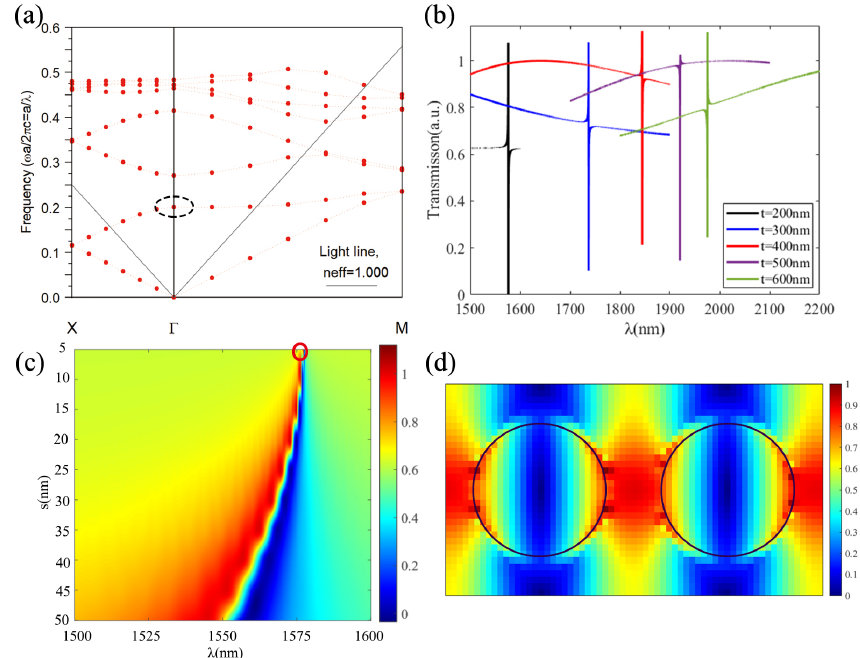
Figure 7. ( a ) Band diagram for rectangular structure with parameters values ra = 0.3, of f Xra = 0.01. The studied slow Bloch mode in Γ -point corresponds to black circle with dotted line. ( b ) Normalized transmission spectra for a = 480 nm, r = 175 nm, s = 5 nm, varying t . ( c ) Normalized transmission spectra for a = 480 nm, t = 200 nm, r = 175 nm, varying s and the red circle corresponds to s = 5 nm. ( d ) Normalized electric field distribution at λ = 1576.42